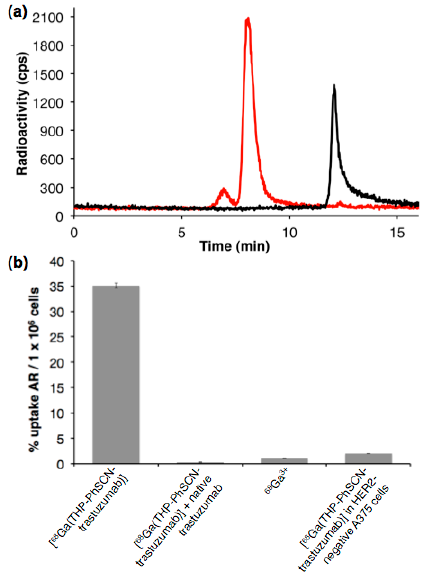
Figure 13. ( a ) Size exclusion radio-HPLC traces of [ 68 Ga(THP-PhNCS-trastuzumab)] ( red ) and [ 68 Ga(EDTA)] − ( black ); and ( b ) In vitro uptake of [ 68 Ga(THP-PhNCS-trastuzumab)] and [ 68 Ga(THP-PhNCS-trastuzumab)] in the presence of an inhibitory concentration of trastuzumab, and 68 Ga 3+ in HER2-positive HCC1954 cells, and [ 68 Ga(THP-PhNCS-trastuzumab)] in HER2-negative A375 cells, after 30 min incubation. Uptake is expressed as a percentage of added radioactivity (AR)/1 × 10 6 cells ( n = 3, error bars correspond to standard error of the